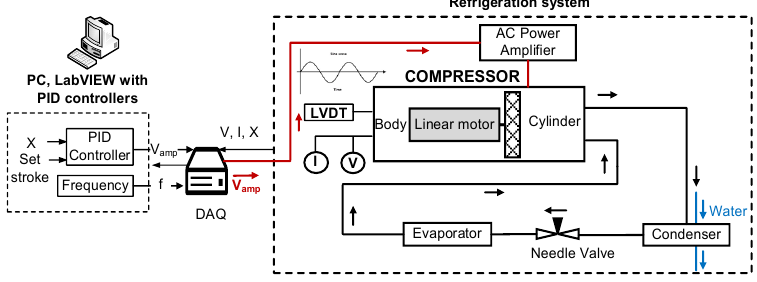
Figure 4. The schematic of the test rig that employed the moving magnet linear motor (LVDT: displacement sensor, V: voltage sensor, I: current transducer).